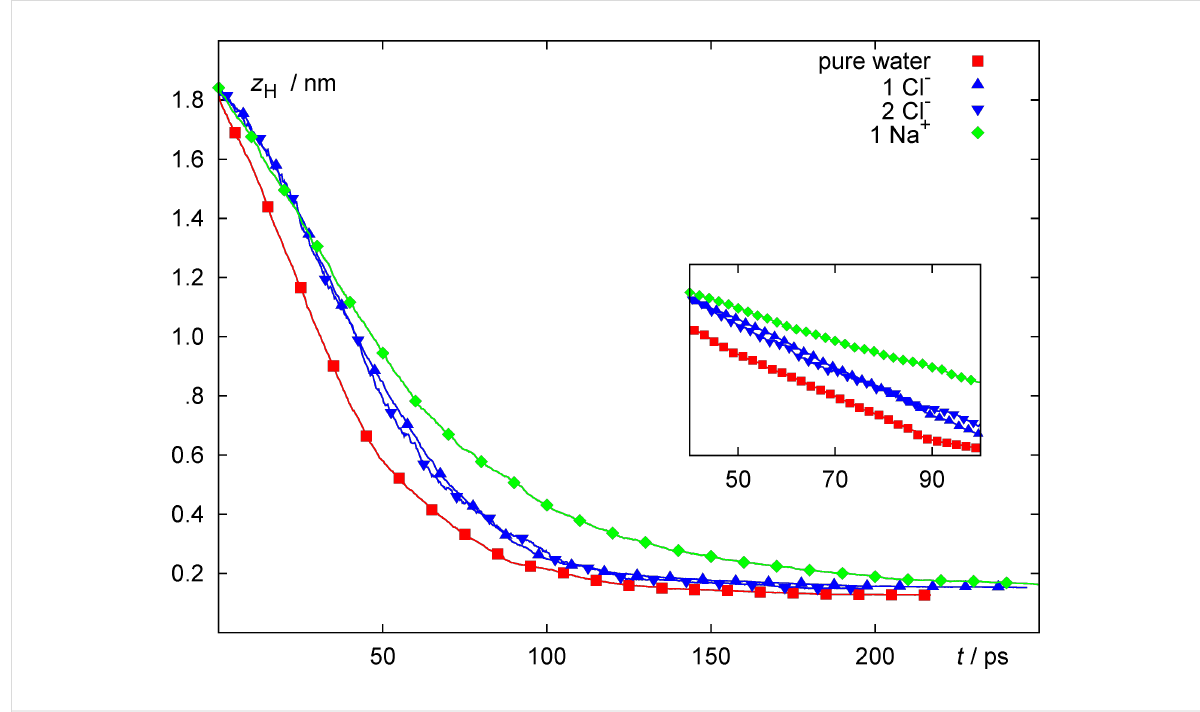
Figure 3: Average proton distance from the metal surface z H as a function of time for pure water (red squares), one or two adsorbed Cl − ions (blue triangles) and one adsorbed Na + (green diamonds). All ions carry a full positive or negative charge. The total surface charge is − 4 e for the Na + system and − 5 e for all other systems. Trajectories are aligned and averaged at their starting time. Inset: logarithmic